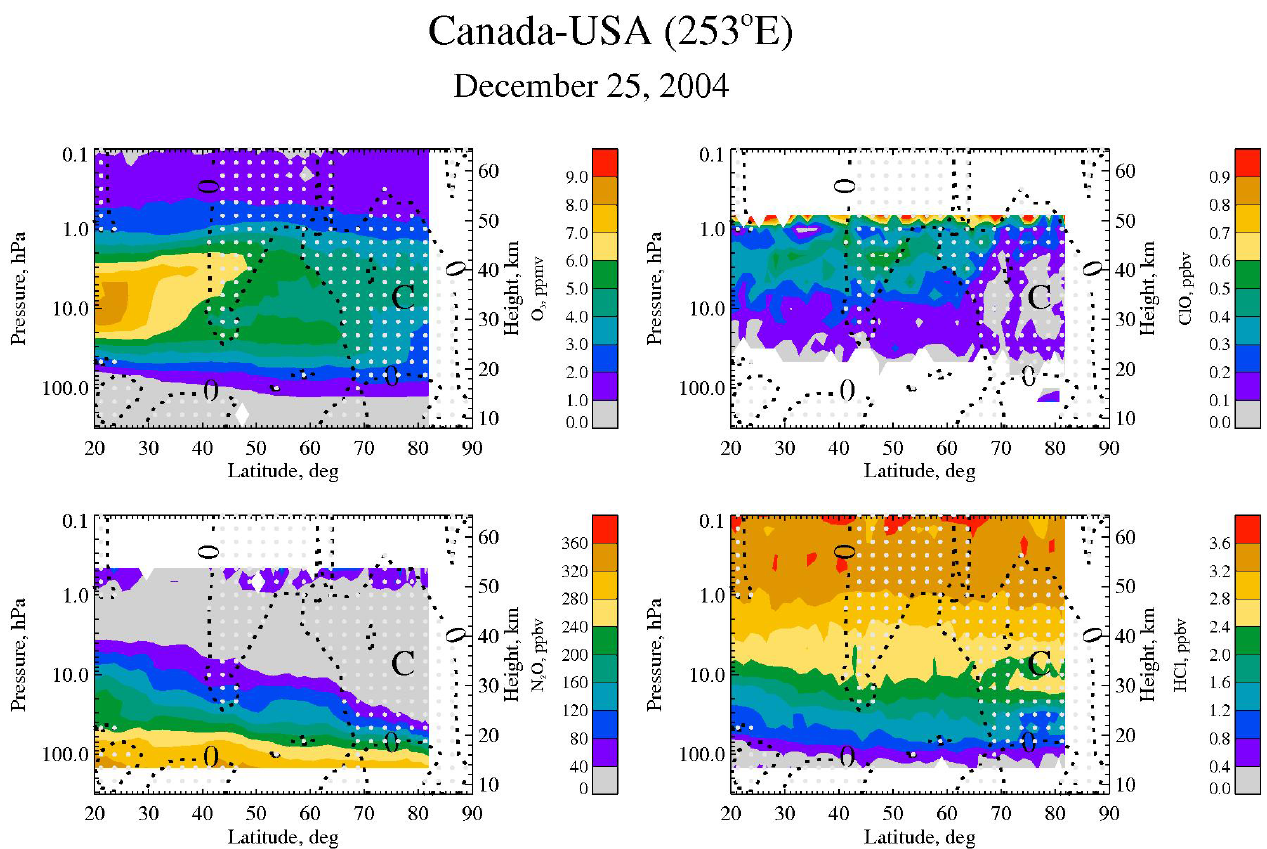
Fig. 4. Contour plots for mixing ratios of four chemicals (Aura MLS) are shown for 25 December, at the chosen longitudinal sector through Saskatoon-Platteville (253 ± 12.5 ◦ E). Regions of negative Q-diagnostic are dotted in white, with their edges dotted in black. The main cyclonic and anticyclonic regions are marked with the letters C and AC. The hemispheric polar vortex edges are close to the southern boundaries of the major cyclonic regions: please see text for any related